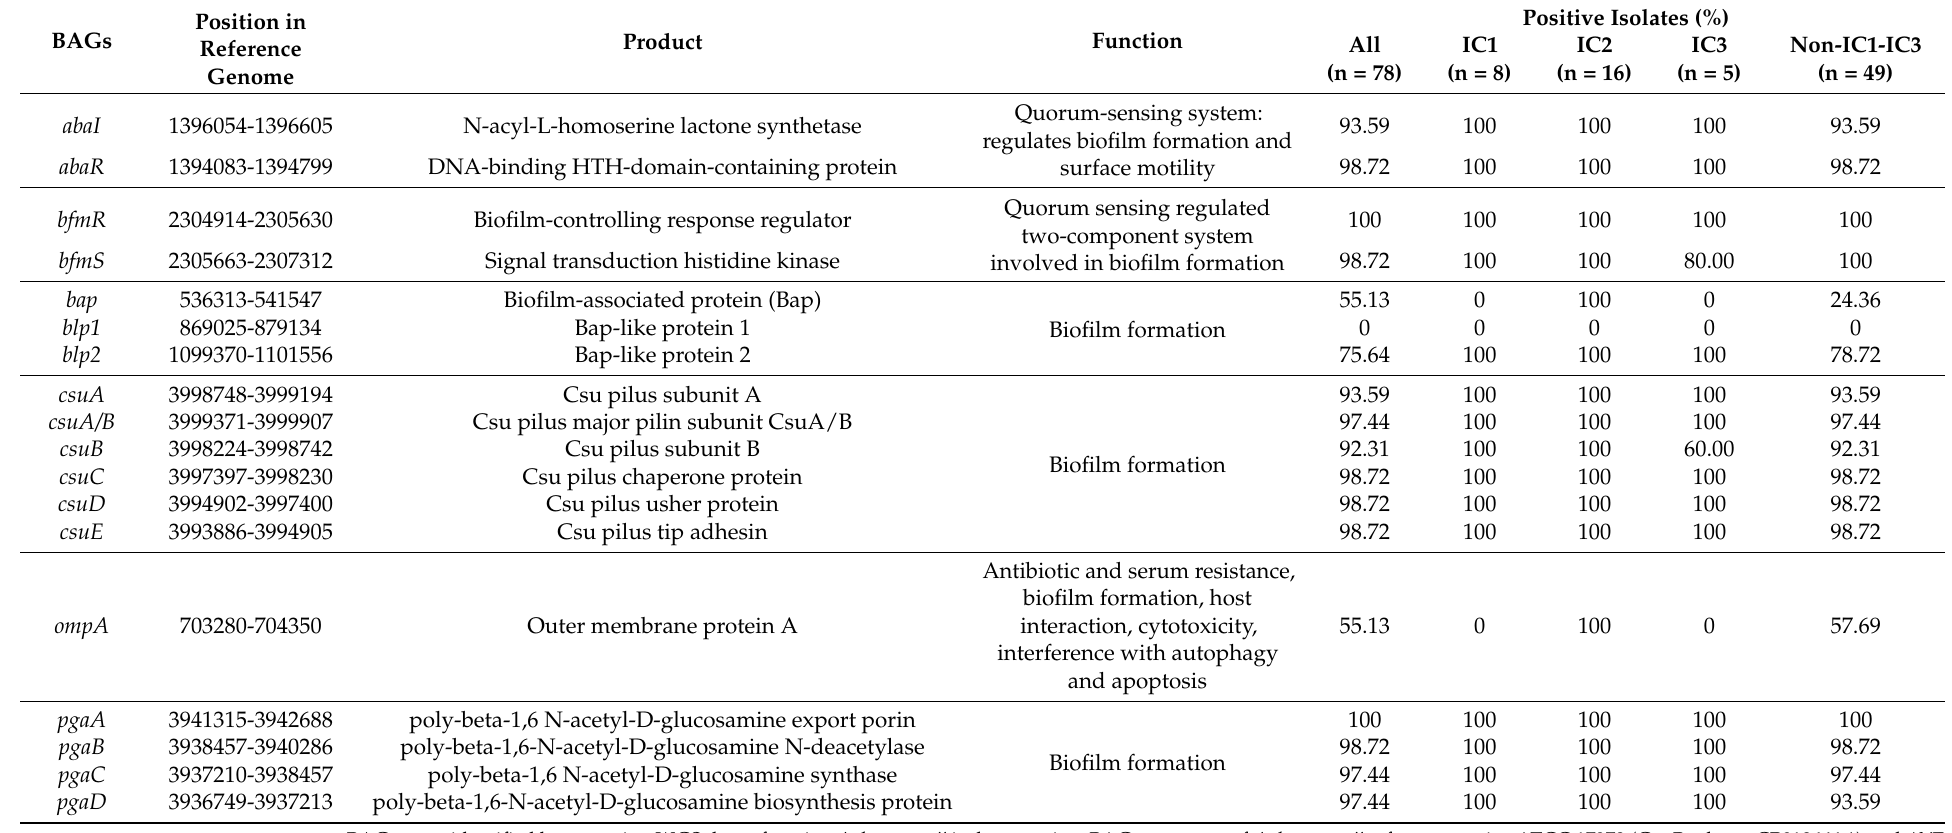
Table 4. Biofilm-associated genes (BAGs) detected in 78 equine A. baumannii